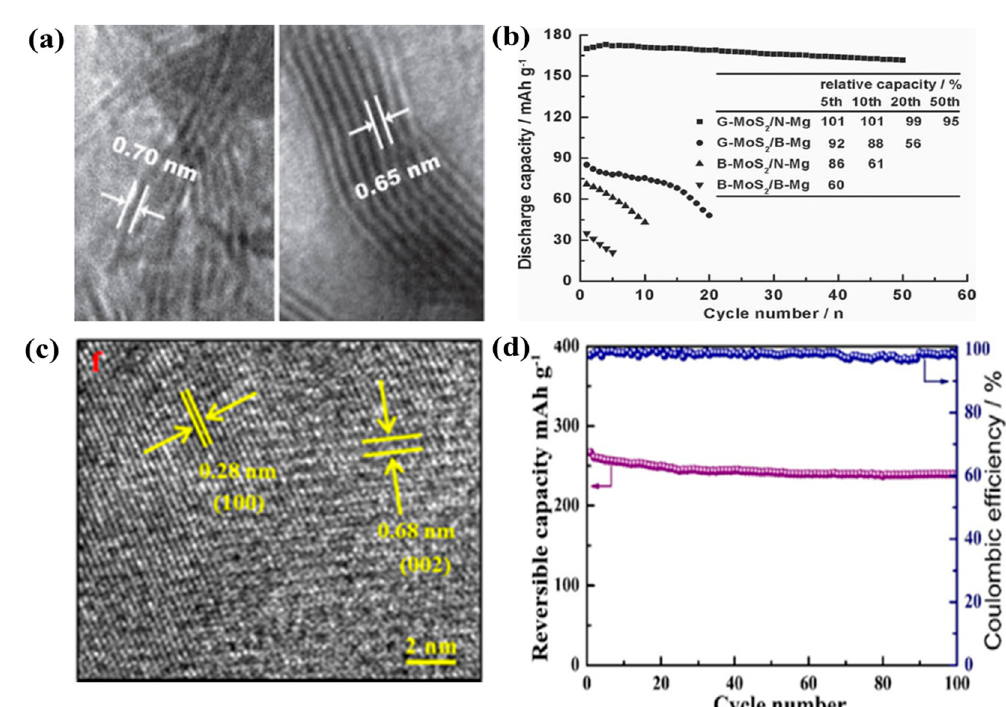
Figure 8. ( a ) TEM image of G-MoS 2 nanosheet, ( b ) cyclic performance of G-MoS 2 and B-MoS 2 with Mg nanoparticle (N-Mg) and bulk Mg (B-Mg) anodes at 20 mA g − 1 . Reprinted with permission from Liang et al. [88] Copyright 2011, WILEY-VCH Verlag GmbH and Co. KGaA, Weinheim.( c ) TEM image of WSe 2 nanosheets, ( d ) cyclic performance of WSe 2 nanosheets at 50 mA g − 1 . Reprinted with permission from Xu et al. [93] Copyright 2020, Elsevier Table 3. Electrochemical performance of TMD cathodes for magnesium-ion batteries (MIBs).